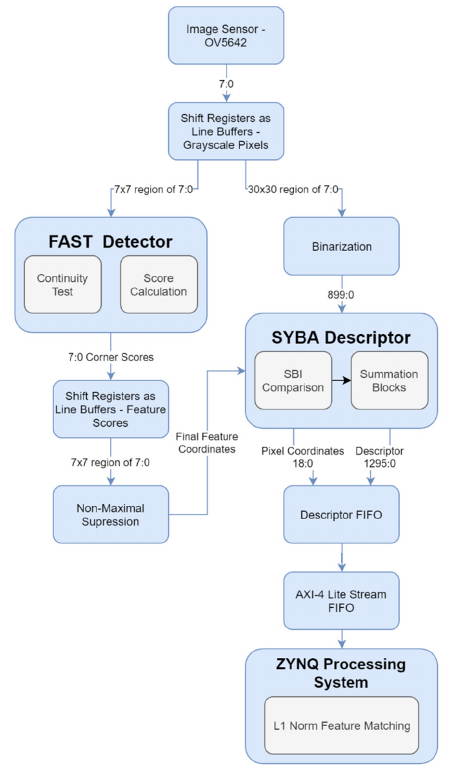
Figure 4. Graphical flow of SYBA (SYnthetic Basis) hardware.